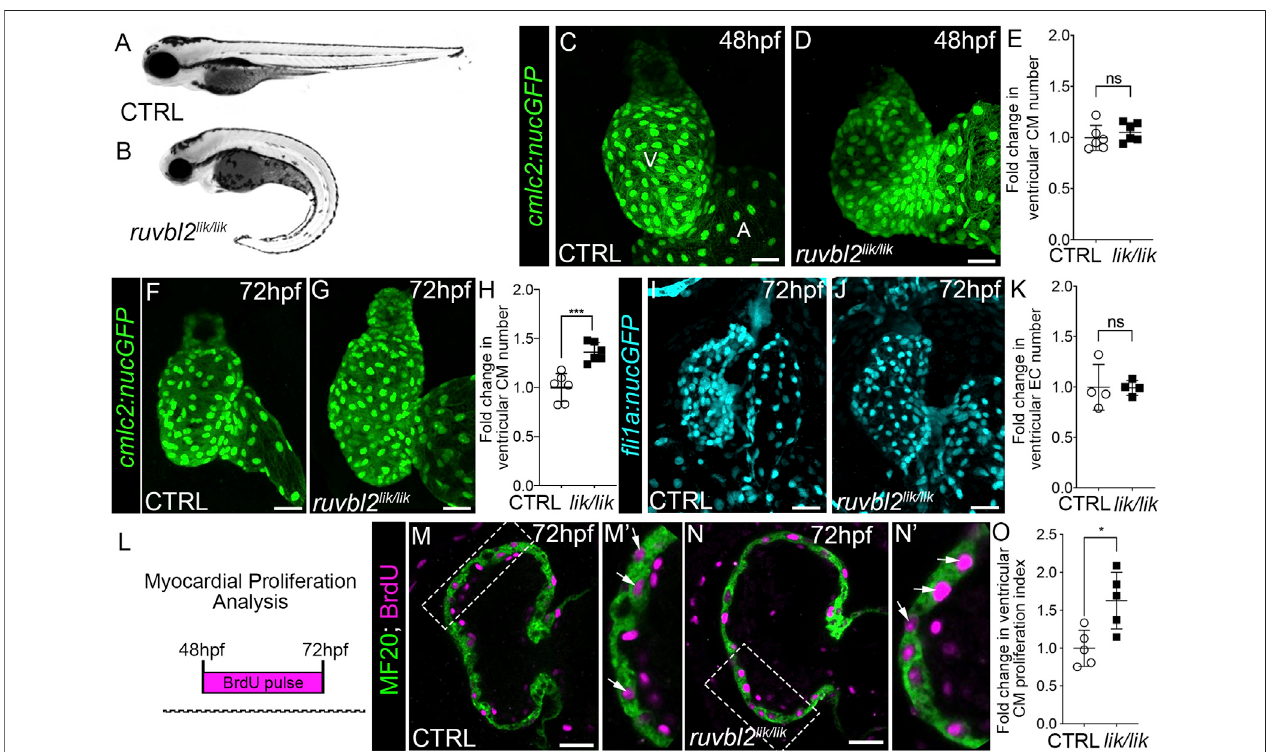
FIGURE 1 | ruvbl2 lik mutant hearts show increased cardiomyocyte proliferation. Bright fi eld images of wild-type (A) and ruvbl2 lik/lik (B) embryos at 72 hpf. Anterior left, lateral view. (C,D) Confocal projections of fl uorescent cardiomyocyte nuclei in hearts of 48 hpf control (CTRL) sibling (C; n = 6) and ruvbl2 lik/lik (D, n = 6) Tg ( cmlc2: nucGFP ) embryos V=ventricle;A =atrium. (E) Quanti fi cation offoldchangein ventricular cardiomyocytenumber in48 hpf CTRLand ruvbl2 lik/lik hearts. Means± s.d are shown. Not signi fi cant (ns); p > 0.05. (F,G) Confocal projections of fl uorescent cardiomyocyte nuclei in hearts of 72 hpf CTRL (F; n = 6) and ruvbl2 lik/lik (G; n = 6) Tg ( cmlc2:nucGFP ) embryos. (H) Quanti fi cation of fold change in ventricular cardiomyocyte number in 72 hpf CTRL and ruvbl2 lik/lik hearts. Means ± s.d are shown. *** p < 0.0005. (I,J) Confocal projections of fl uorescent endocardial nuclei in hearts of 72 hpf CTRL (I; n = 4) and ruvbl2 lik/lik (J; n = 4) Tg ( fl i1a:nucGFP ) embryos. (K) Quanti fi cation of fold change in ventricular endocardial cell number in 72 hpf CTRL and ruvbl2 lik/lik hearts. Means ± s.d are shown. Not signi fi cant (ns); p > 0.05. (L) SchematicrepresentingthemyocardialproliferationassaybyBrdUpulsebetween48and72 hpf. (M – N 9 ) SingleplaneconfocalimagesofCTRL(M; n =5)and ruvbl2 lik/lik (N; n = 5) hearts double immunostained todetect cycling(BrdU+) cardiomyocytes (MF20+) at 72 hpf. Boxed regions in (M,N) are magni fi ed in (M 9 ,N 9 ) with whitearrows highlighting double positive cells. (O) Quanti fi cation of cardiomyocyte proliferation indices in CTRL and ruvbl2 lik/lik ventricles. Means ± s.d are shown. * p < 0.05. Scale bars: 25 μ